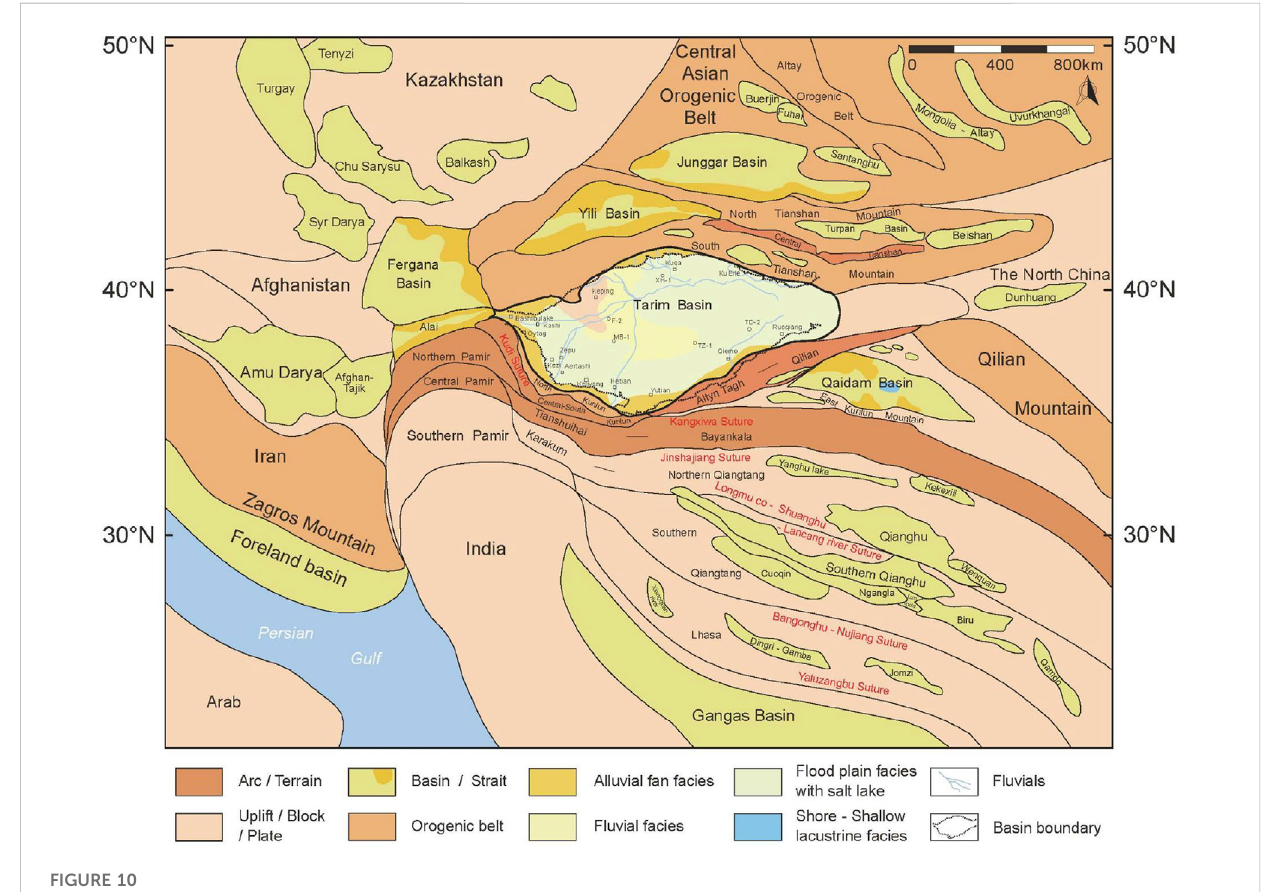
FIGURE 10 Tectono-paleogeography map around the Tarim Basin in the Late Neogene.